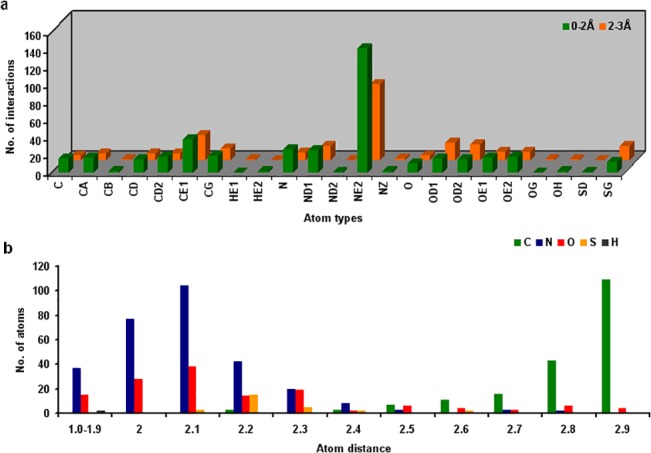
Atom preferences in nickel coordination.Figure represents a) the various atom types coordinating with the Nickel and b) shows the interactions distances of atoms with the metal.